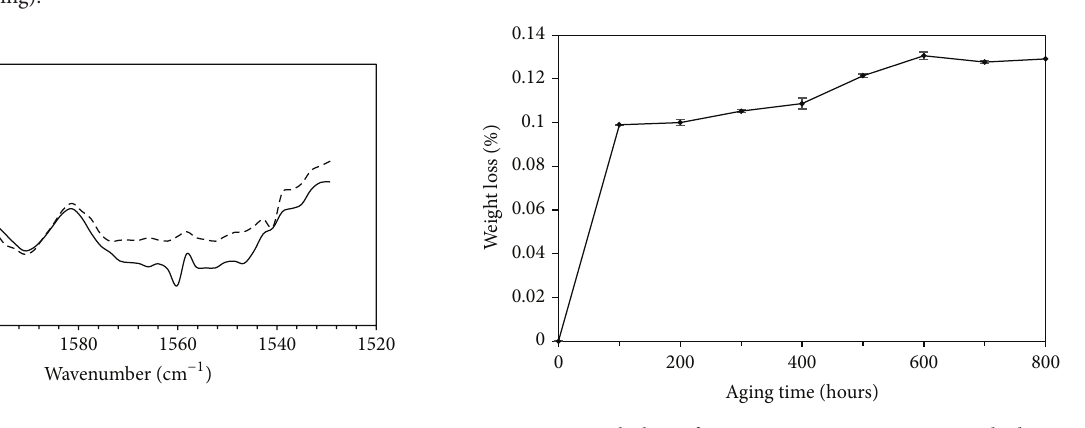
Figure 12: Weight loss of EHG250-68-37 composite sample during 800 hours of aging at 82 ∘